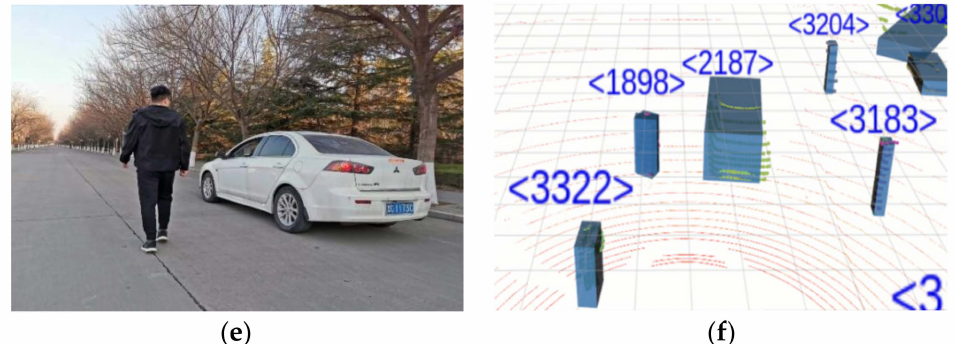
Figure 7. Obstacle data-association results. ( a ) Original scene view at frame 70, ( b ) frame 70 point cloud data, ( c ) original scene view of frame 100, ( d ) frame 100 point cloud data, ( e ) original scene view of frame 130, ( f ) frame 130 point cloud data.